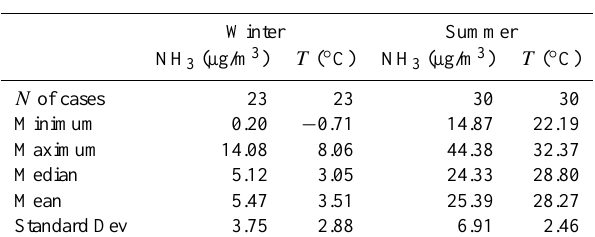
Table 1. Statistics for NH 3 and T during the winter and summer campaigns at PKU